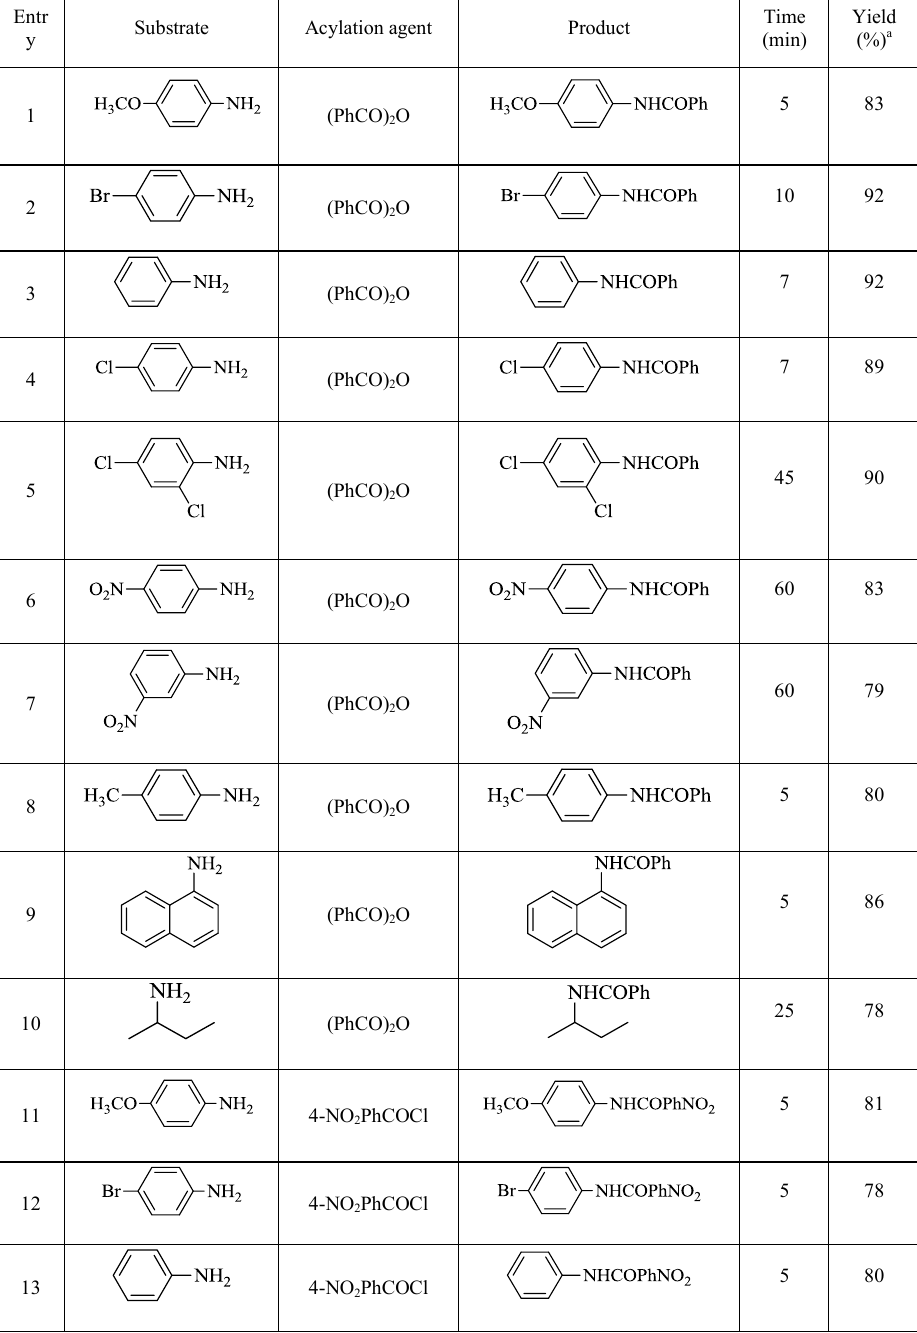
Table 2. Hydrotalcite catalyzed acylation of amines under solvent-free conditions. Entr y